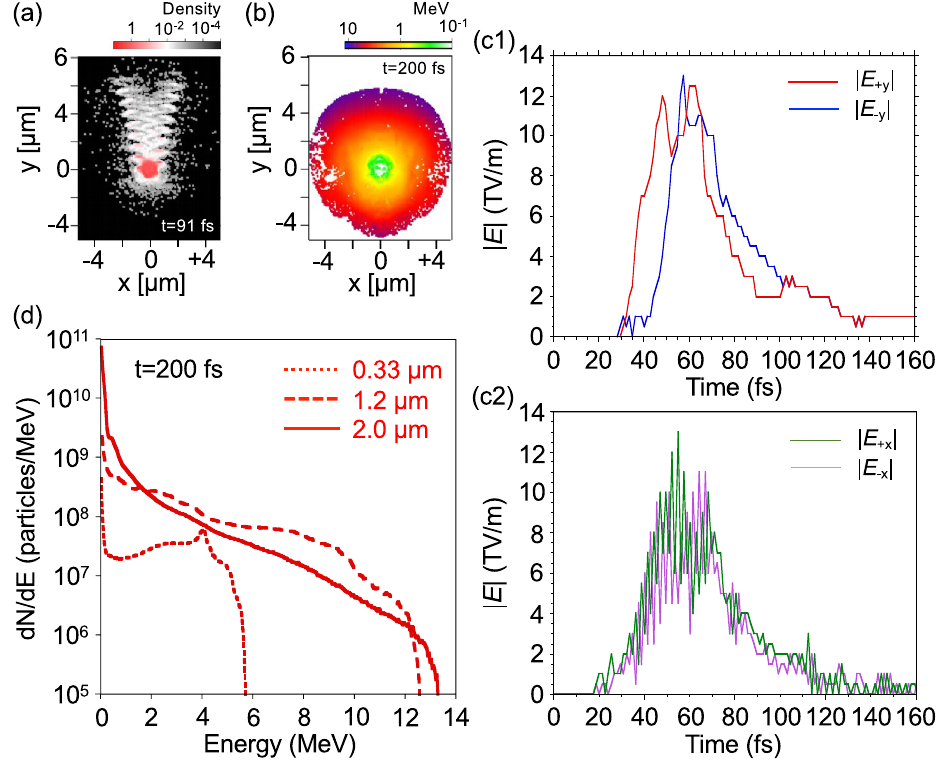
Figure 5. Anisotropic ambipolar expansion of the micron-scale hydrogen clusters. 2D images of ( a ) electron density and ( b ) ion kinetic energy distributions in the x–y plane for a hydrogen cluster with a diameter of 1.2 µ m at different times. The density is normalized by the initial charge density of the cluster electrons and displayed on a log scale. Temporal evolutions of electric field intensity at the exploding front of the cluster ( c1 ) in the laser propagation direction and ( c2 ) in the transverse direction for a hydrogen cluster with a diameter of 1.2 µ m. ( d ) Proton energy spectra for clusters with diameters of 0.33, 1.2, and 2.0 µ m. The proton number is evaluated using a real value by multiplying the particle weight by the PIC particle